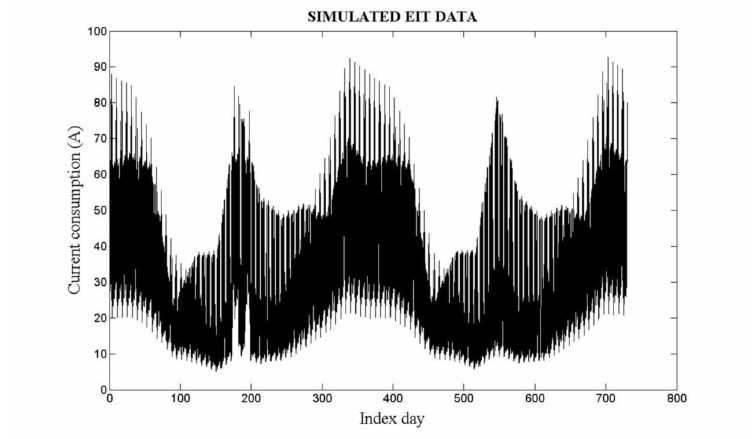
Figure 6. Simulated EIT—17,520 measurements obtained during 730 days.